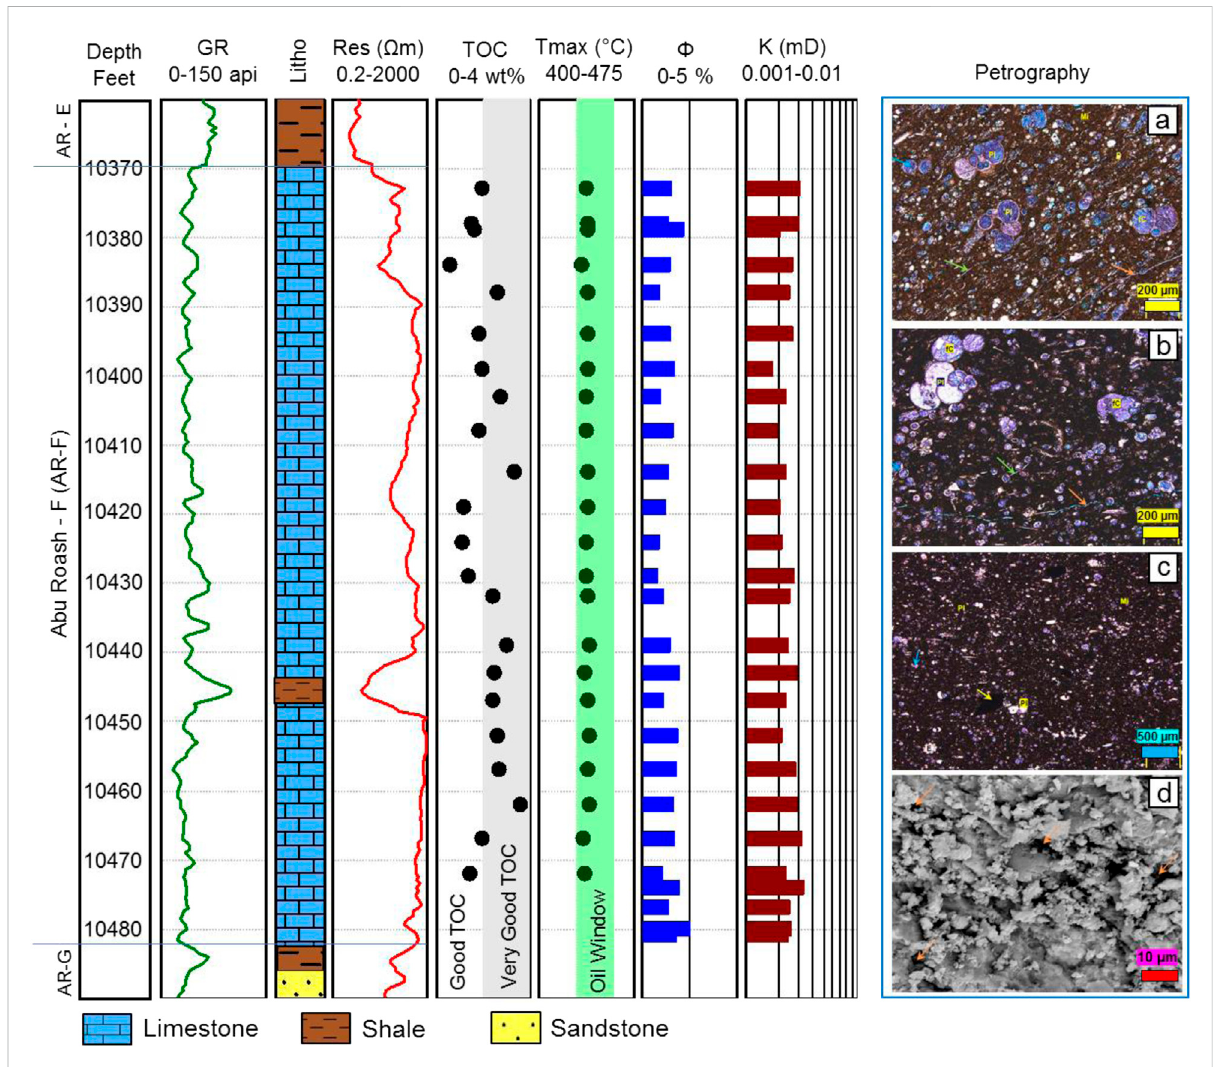
FIGURE 2 Geochemical(TOCandT max fromRock-Evalpyrolysis),petrophysicalproperties( Φ andKfromroutinecoreanalysis),petrographicthinsections and SEM image of the studied AR-F interval. Thin sections (A – C) indicate the presence of micrite matrix along with frequent planktic foraminifera, minor pelagic bivalves (green arrow), black pyrite crystals (yellow arrows), and thin fractures (orange arrows); (D) SEM indicates isolated